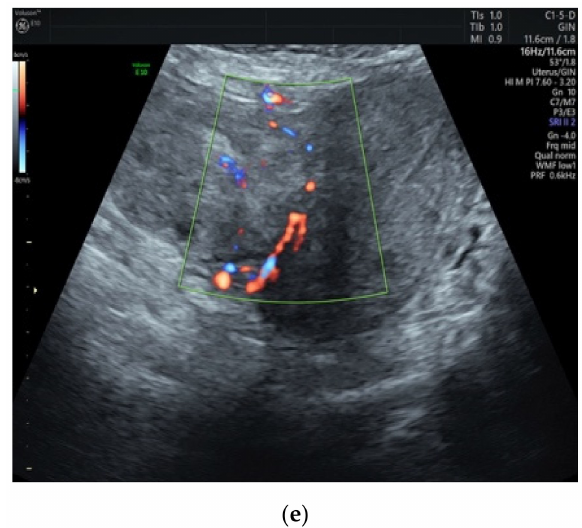
Figure 2. Uterine cotyledonoid dissecting leiomyoma and ultrasound features. Different US features of uterine cotyledonoid dissecting leiomyoma: note in ( a ) irregular margins and heterogeneous aspect of the mass; no evidence of capsule, no shadowing; ( b ) hypervascularization compared with the vascularity of the myometrium, color score 3; ( c , d ) the presence of colliquated areas; ( e ) note the uterus on the right side and the lesion on the left side emerging from the lateral wall of the uterine corpus. With the application of color doppler, the vascularization is visualized with color red and blue, in images ( b – e